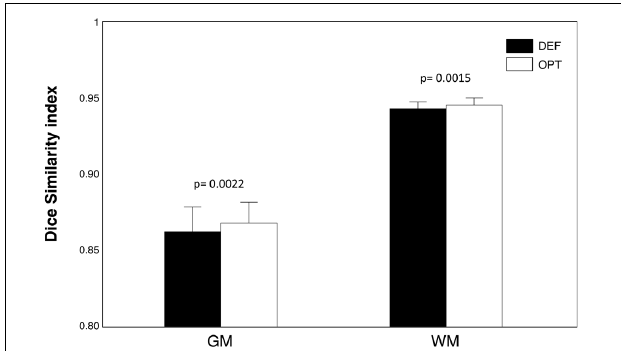
FIGURE 9 | Test–Retest analysis of INU correction performance. We used the full set of KIRBY21 images to perform a test–retest reliability analysis. As an indirect measure of INU correction performance, we employed the DSI between GM (and WM) segmented volumes. We compared the DSI values obtained from the optimized and default parameter configurations using paired t -tests. The bar plots show mean and standard error for GM and WM masks, and for optimized (OPT) and default (DEF) configurations, respectively. The probabilities estimated using the t -tests are indicated in the figure as